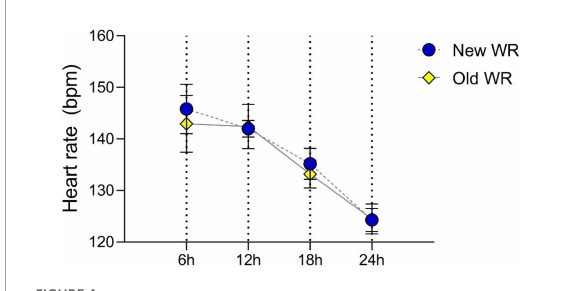
FIGURE4 Heart rate (bpm) mean (standard deviation) for the two records by time intervals (6; 12 h; 18 and 24